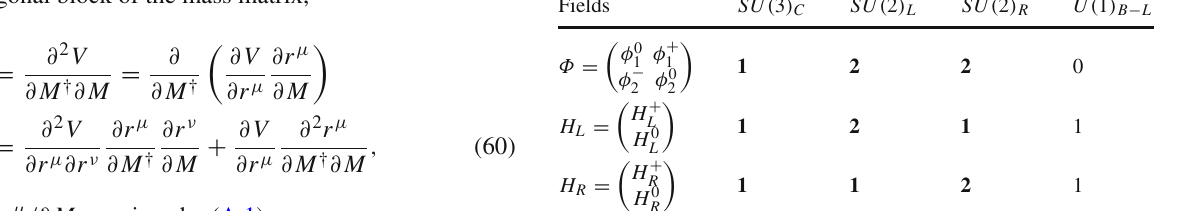
Table 1 Scalar fields and their representations in the left-right model